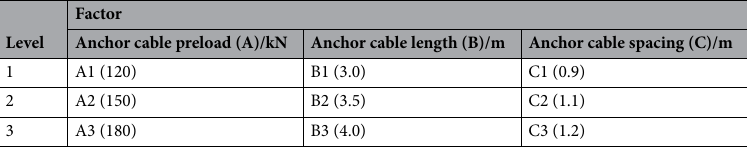
Table 3. Factors and levels table.